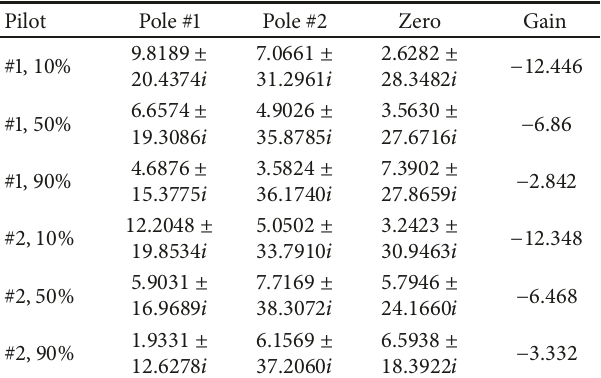
Table 1: Poles, zeros, and gains of transfer functions identified at the Bibby flight simulation